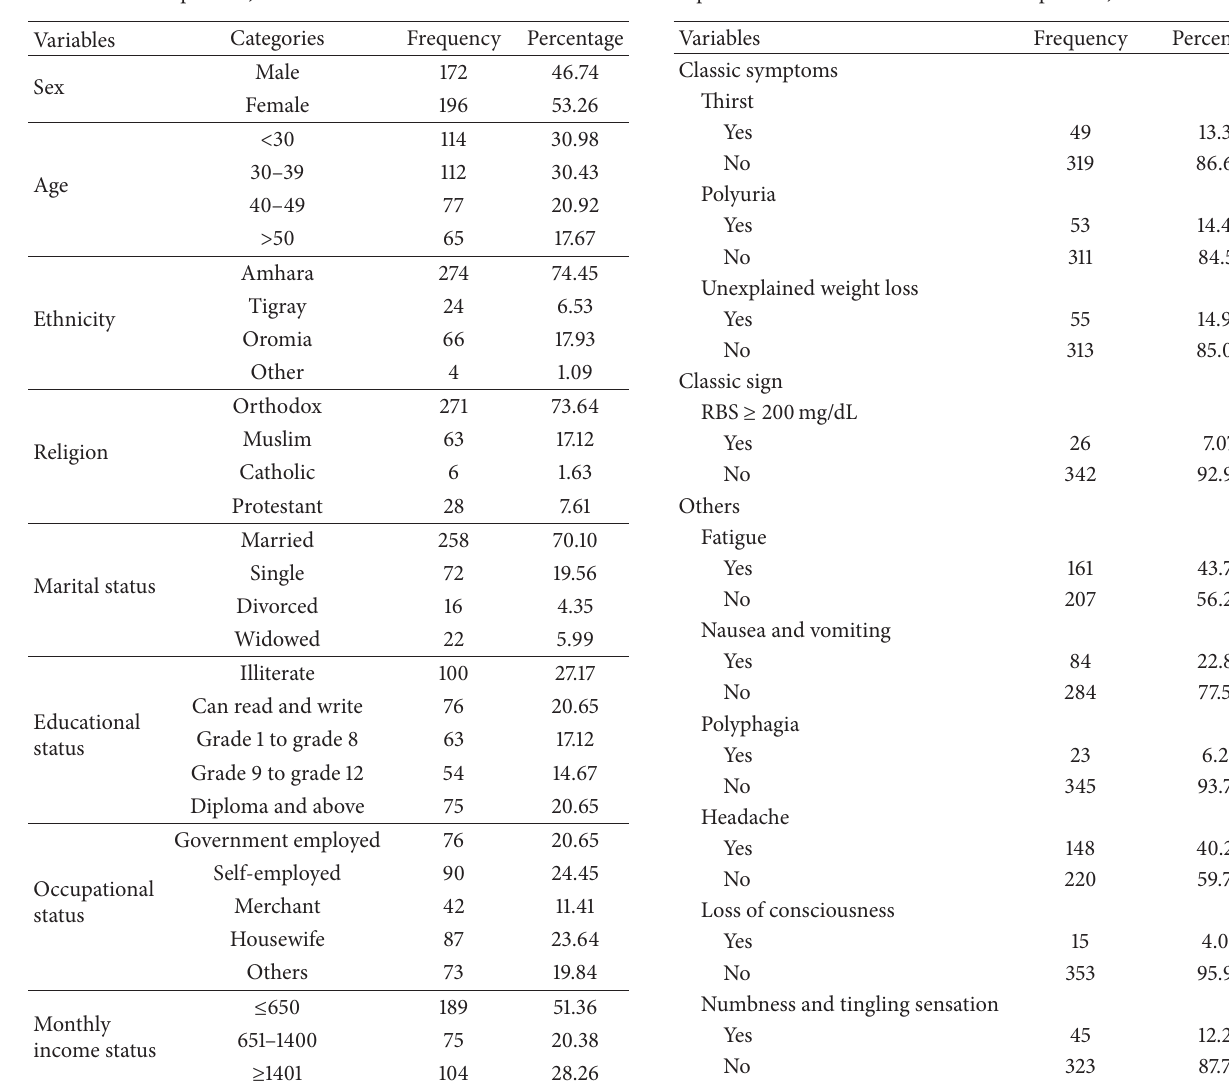
Table 1: Sociodemographic characteristics of patients in Debre Ber- han Referral Hospital in June 2015.